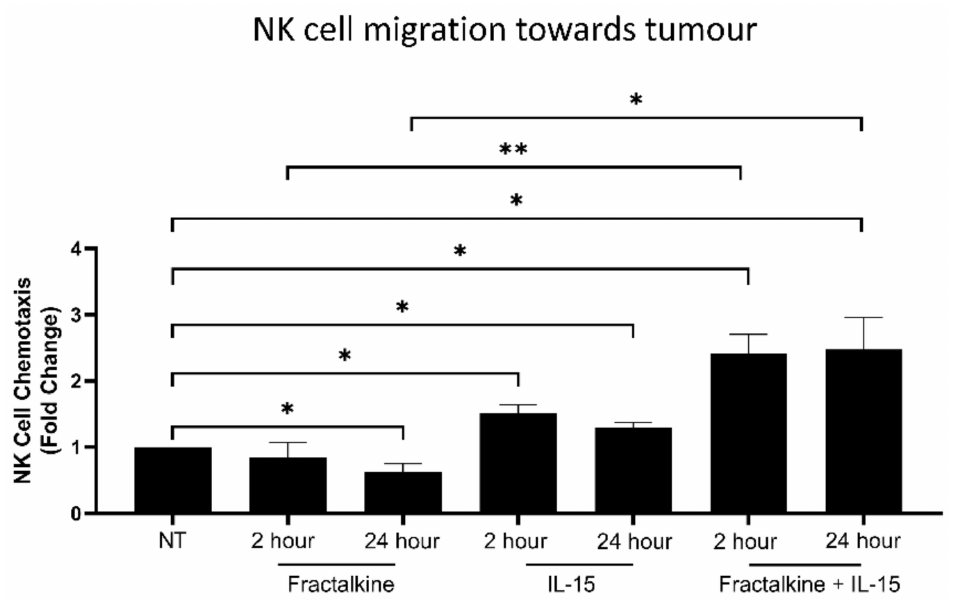
Figure 3. Fractalkine-induced impedance of NK cell migration to OAC tumour-derived conditioned media can be overcome by IL-15. Bar chart showing the fold-change migration of NK cells to OAC patient-derived TCM following no treatment, treatment with 100 ng/mL of fractalkine and/or IL-15 ( n = 3–6). Paired t test, * p < 0.05, ** p <